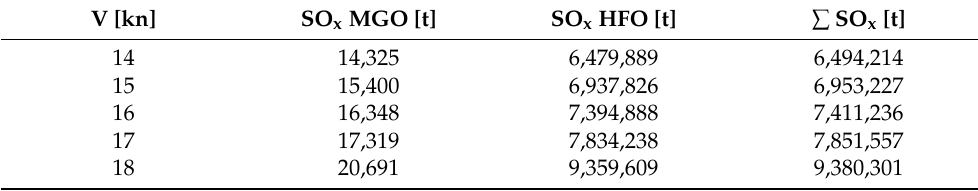
Table 5. Estimated figures for SO x emissivity generated by container shipping in 2018. V [kn] SO x MGO [t] SO x HFO [t] ∑ SO x [t]